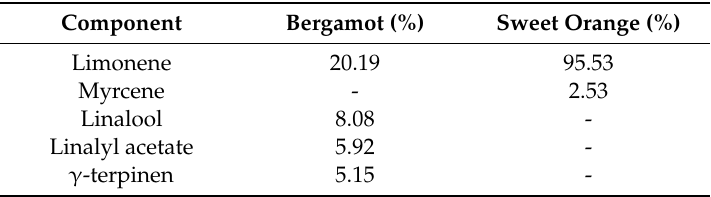
Table 1. Analysis of oils by gas chromatography (only the main compounds responsible for antibacterial were reported).